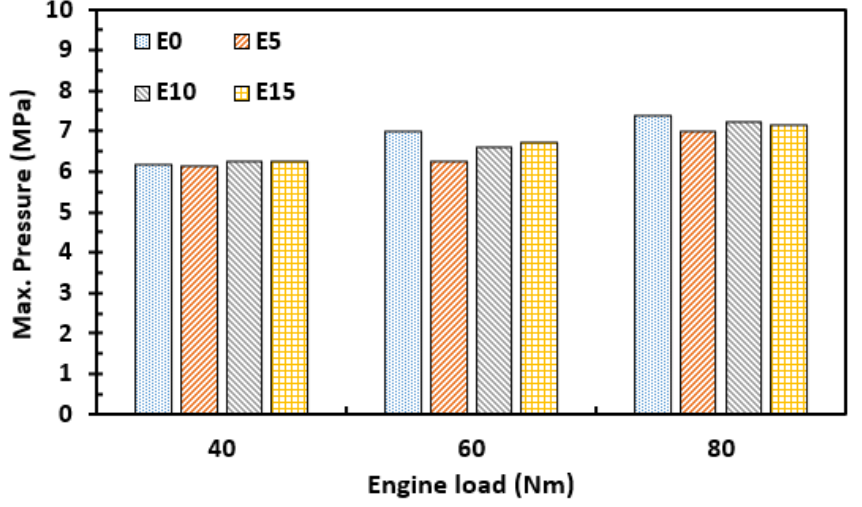
Figure 4. Peak combustion pressure in the cylinder.